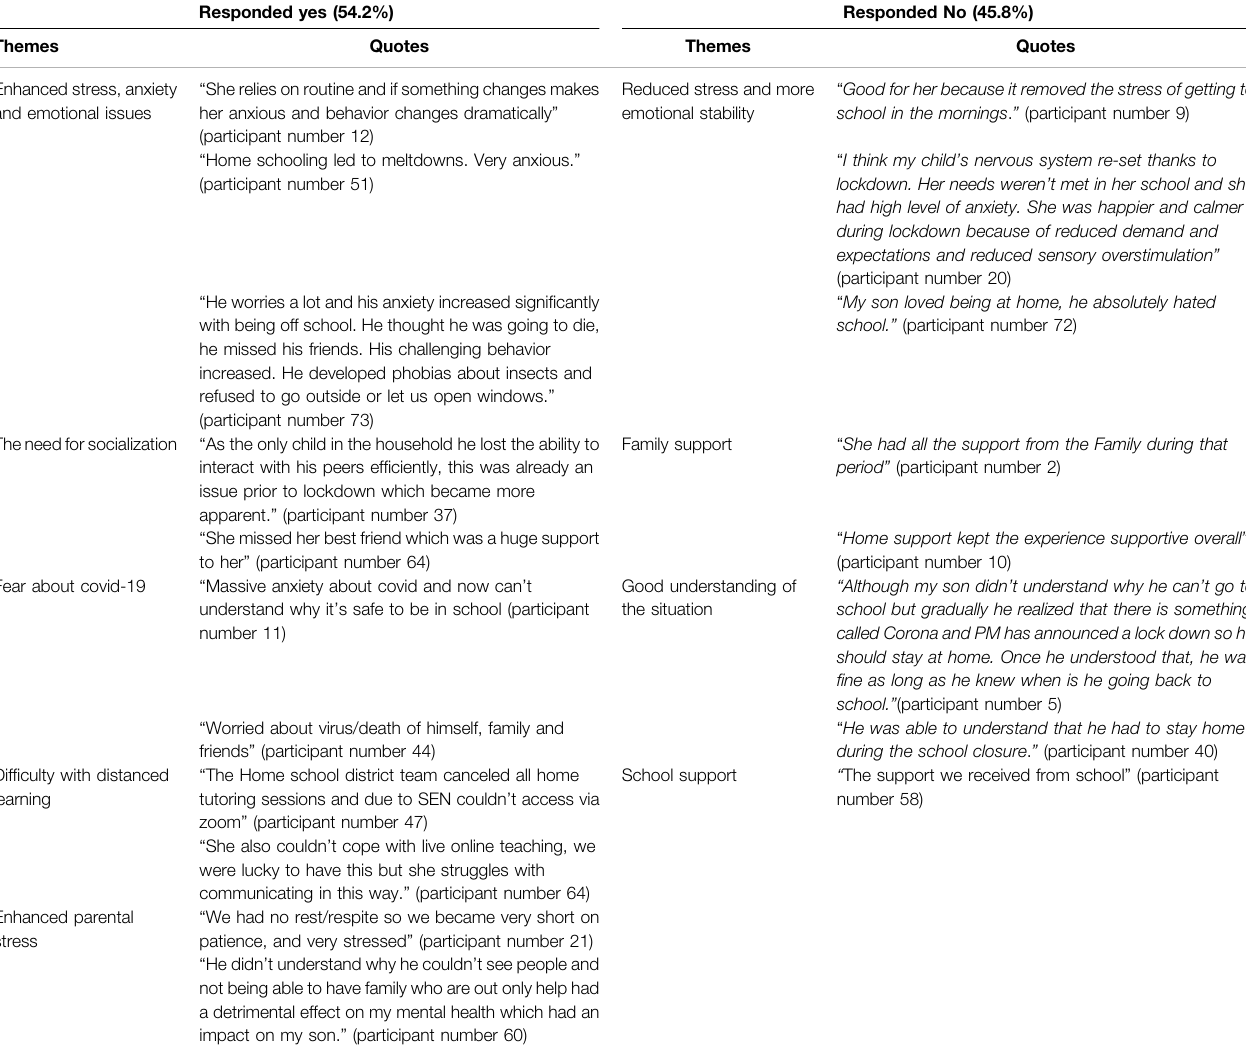
TABLE2| Themesandquotesresultingfromtheanalysisofresponsestotheitems “ Doyouthinkthatschoolclosureshadadetrimentaleffectonyourchild ’ smentalhealth? ” and “ Please tell us why ”